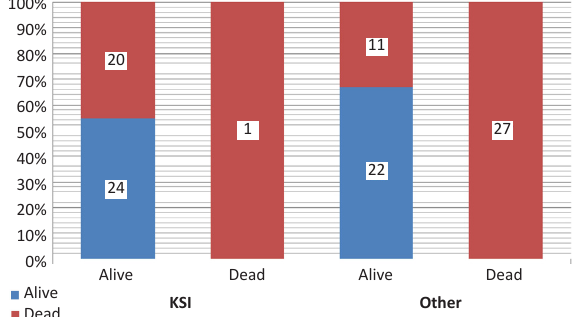
Figure 7. Impact of kite string injuries and other causes for encoun- ters on survival